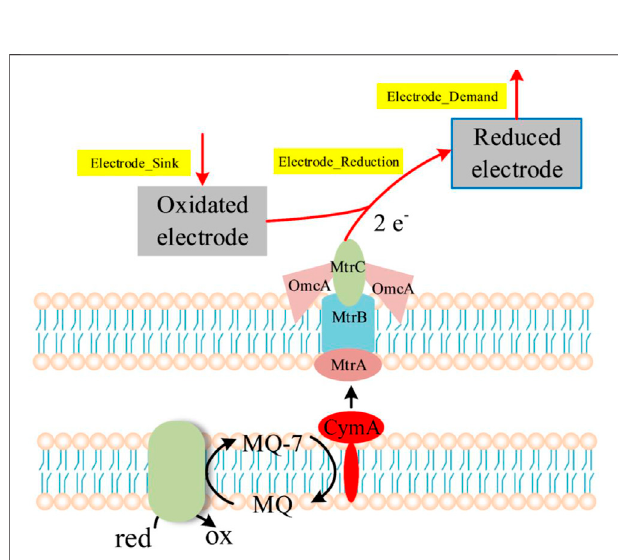
FIGURE 5 | Respiratory electron transport in MFCs based on S. oneidensis MR-1. The arrows in the dotted box represent the reactions used for the simulation of electron